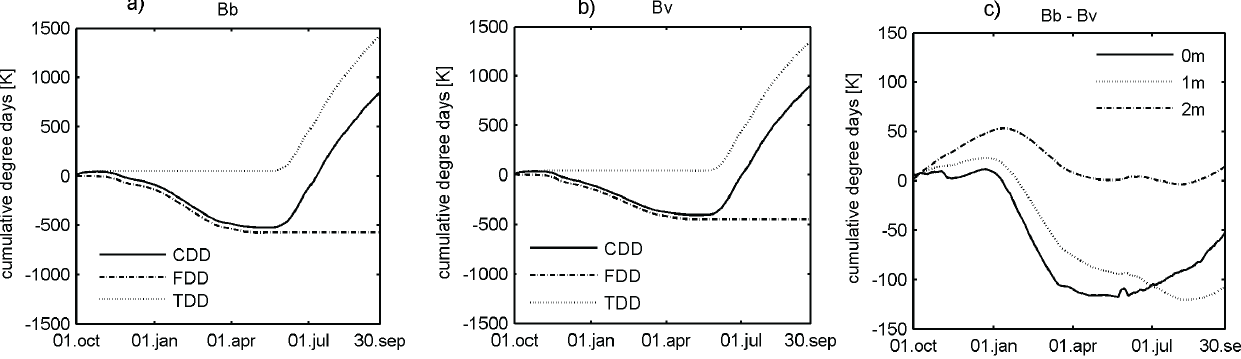
Fig. 9. Cumulative degree days (CDD) (averaged over four years (2003, 2005, 2006, 2010)) at the surface (0m depth) for bare bedrock (Bb) (a) and vegetated bedrock (Bv) (b) . Freezing degree days (FDD) are all days ≤ 0 ◦ C, whereas the days with temperatures > 0 ◦ C were set to 0. Likewise, the thawing degree days (TDD) are the days with temperatures > 0 ◦ C so temperatures ≤ 0 ◦ C were set to 0. For (c) the mean cumulated temperature difference between the vegetated and the bare bedrock site for 0m, 1m and 2m depth was calculated. annual range of the ATD (2x 10 − 6 - 3.45x 10 − 6 m 2 s − 1 ).